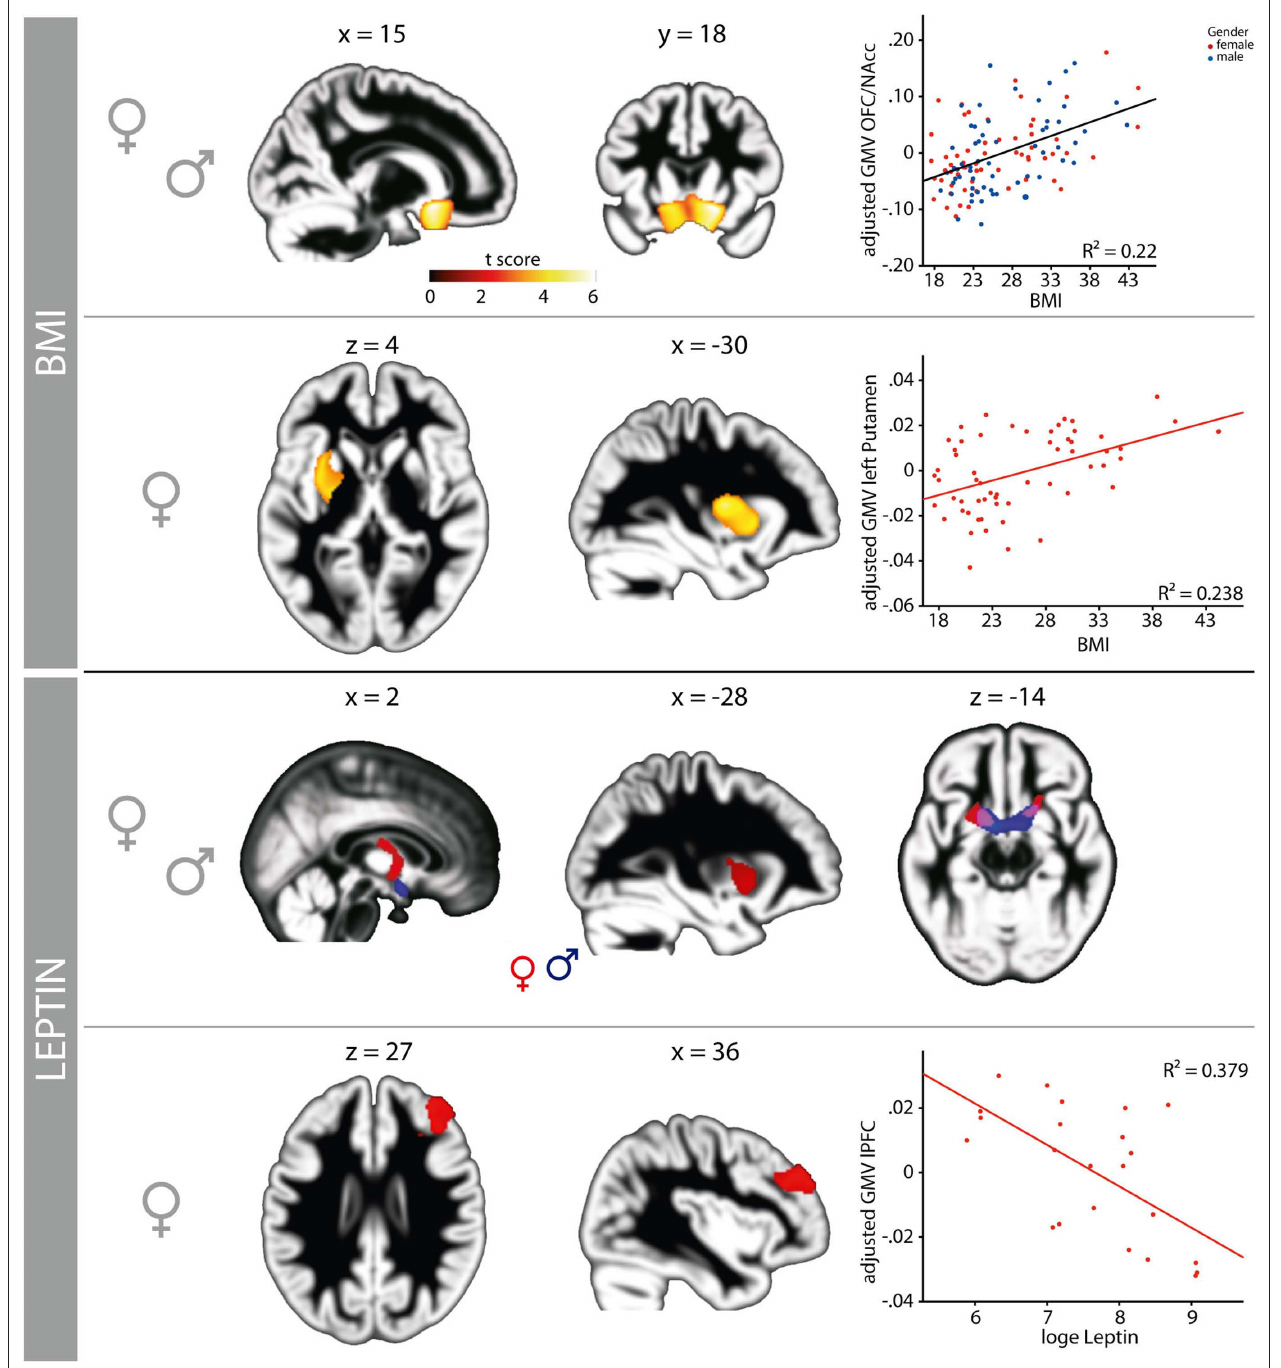
and GMV in the left putamen overlaps with the association between the concentration of central leptin and GMV in the putamen, an effect, which we only find in women (third panel: red). Women show additional alterations in the NAcc bilaterally and the fornix (third panel, red); men show alterations of brain structure in the NAcc bilaterally and the hypothalamus (third panel, blue). We found a significant negative association between central leptin and GMV restricted to women in the right lateral prefrontal cortex (lower panel). All GMV values are mean standardized and corrected for age, total gray and